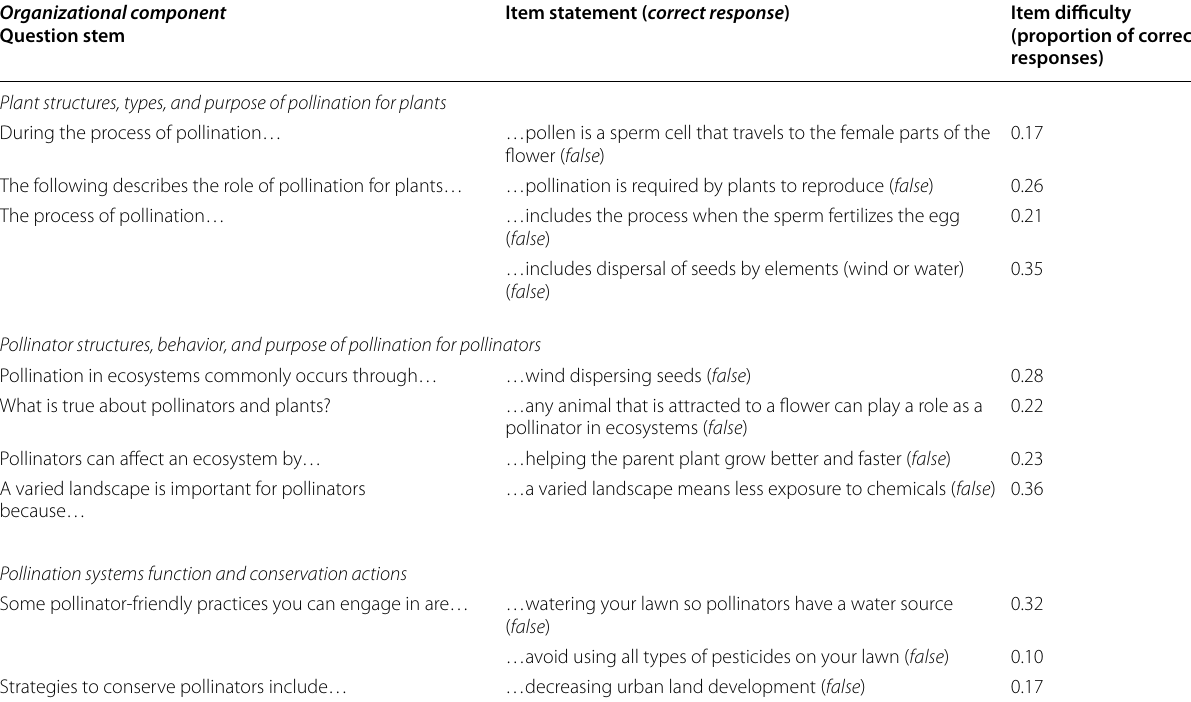
Table 2 List of items from the PSKA that 40% or fewer students answered correctly in Spring 2019 (n component from Golick et al.’s (2018)